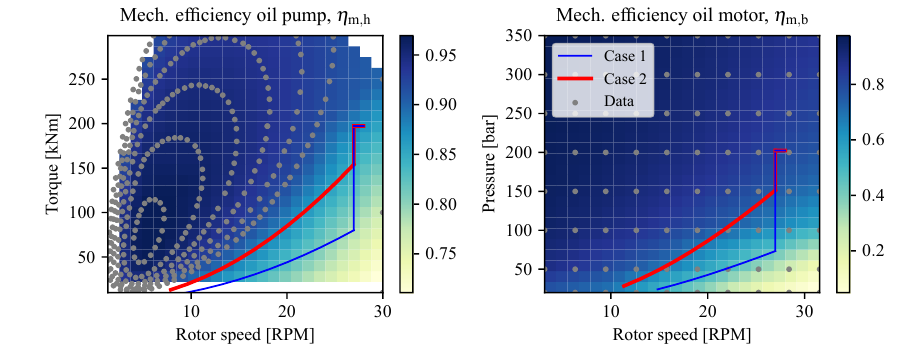
Figure 13. Mechanical efficiency mapping of the oil pump and oil motor. Manufacturer-supplied data (blue dots) are evaluated using an interpolation function. Operating cases 1 and 2 are indicated by the solid blue and red lines, respectively.